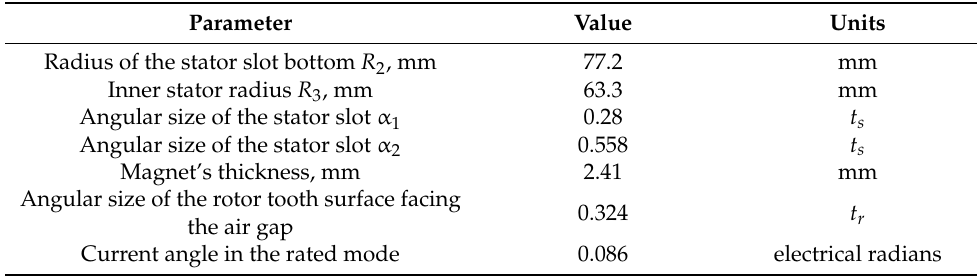
Table 8. Optimized values of the varied parameters of the PMFSG. Parameter Value Units Radius of the stator slot bottom R 2 , mm